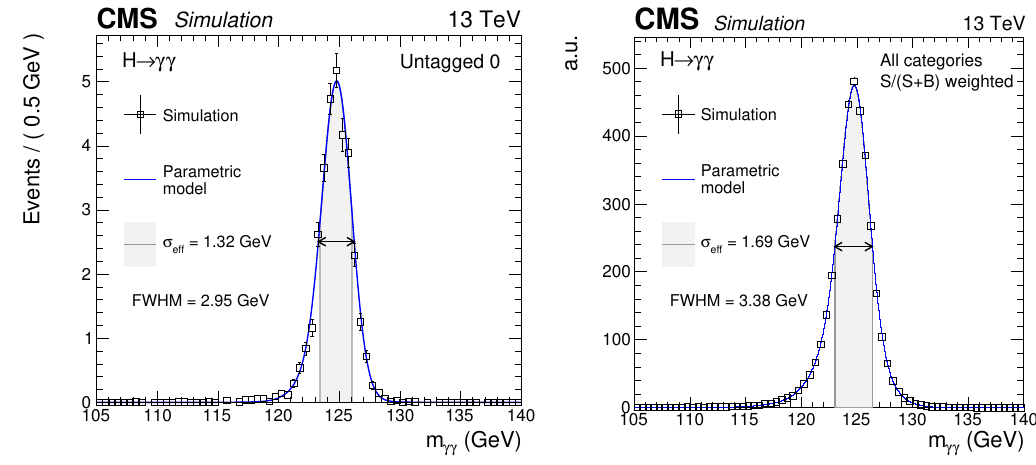
Figure 8 . Parametrized signal shape for the best resolution category (left) and for all categories combined together and weighted by the S = (S+B) ratio (right) for a simulated H ! (cid:13)(cid:13) signal sample with m H = 125 GeV. The open squares represent weighted simulated events and the blue lines are the corresponding models. Also shown are the (cid:27) e(cid:11) value (half the width of the narrowest interval containing 68.3% of the invariant mass distribution) and the corresponding interval as a grey band, and the full width at half maximum (FWHM) and the corresponding interval as a double